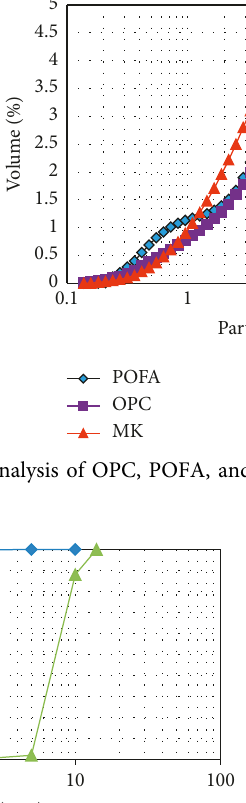
Coarse Aggregate Figure 3: Coarse and fine aggregate sieve